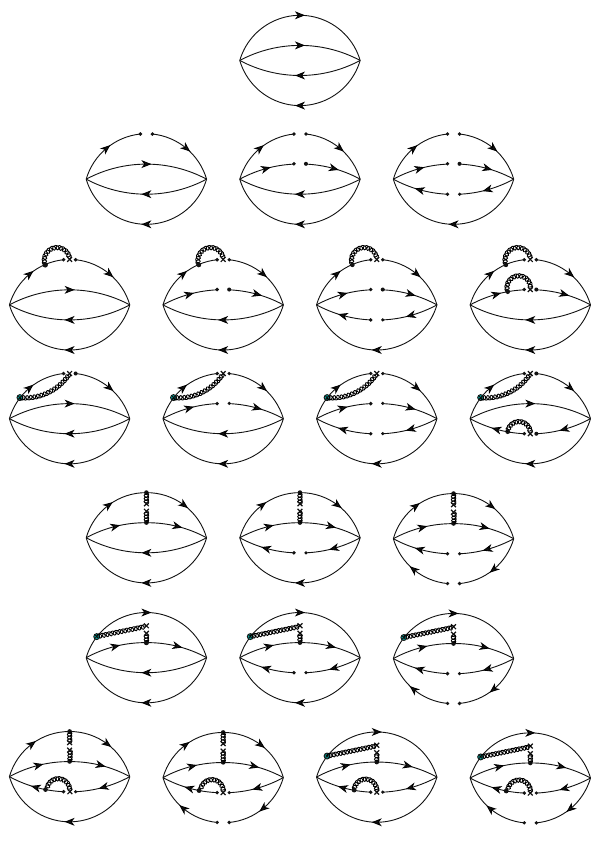
Fig. 3 Feynman diagrams for the fully-strange tetraquark currents of J PC = 4 +− . The covariant derivative operator D α = ∂ α + ig s A α contains two terms, and we depict the latter term using a green vertex